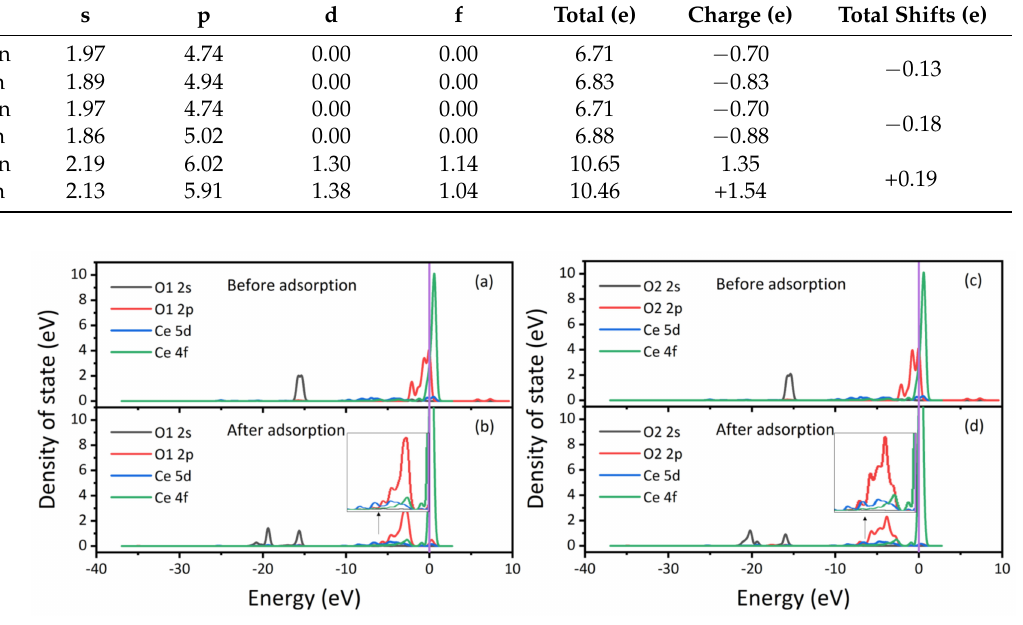
Figure 11. Density of states of Ce and O ( a , c ) before and ( b , d ) after the adsorption of Al(OH) 3(s) on the bastnaesite (100) surface. Table 8. Bond and population analyses for adsorption on the bastnaesite (100) surface